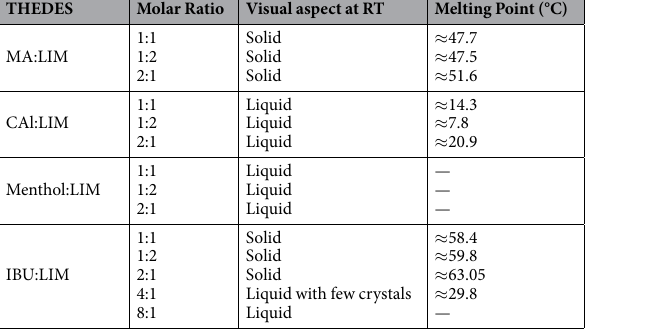
Table 1. Summary of the different THEDES